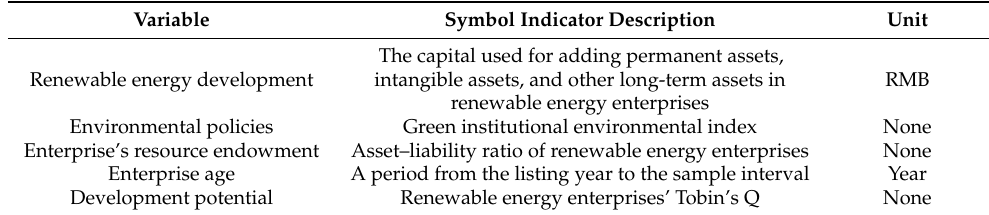
Table 1. Description of main variables and